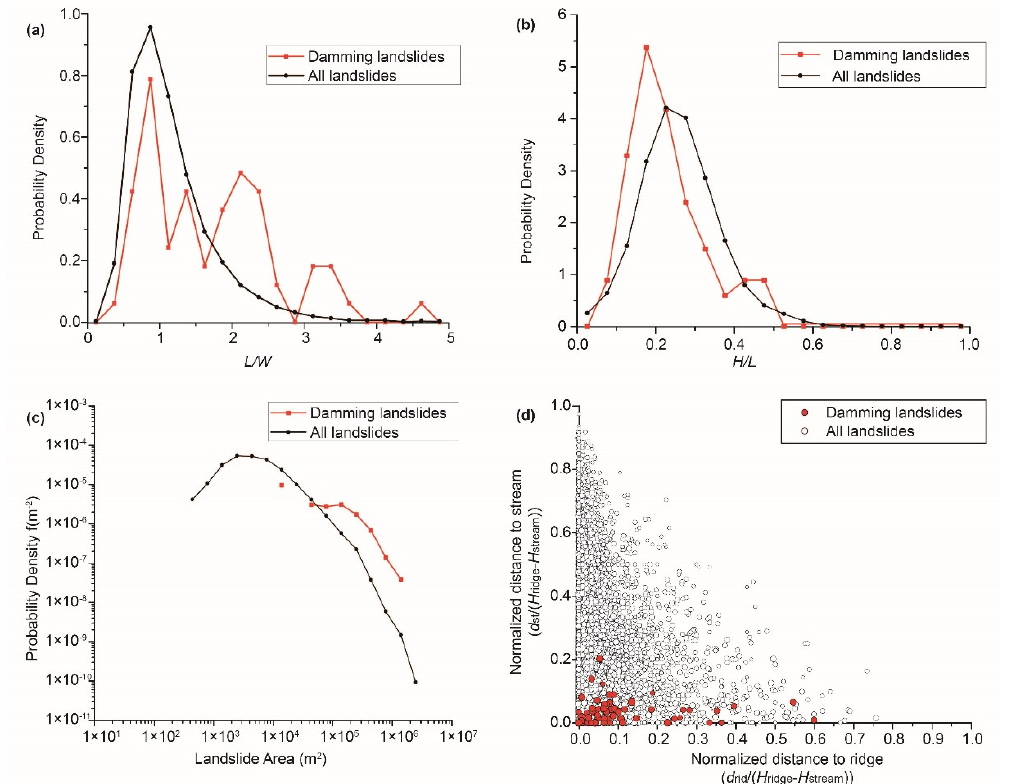
Figure 10. Geomorphic attributes of the Haiyuan coseismic damming and non-damming landslides (landslide data after Xu et al., 2021) [21]. ( a ) Aspect ratios of landslides. ( b ) Equivalent coefficients of friction. ( c ) Areas of landslides. ( d ) Normalized distances to ridges and streams, revealing the coseismic landslide distribution in slope portions. The horizontal axis is the normalized distance of the landslide boundary to the top of the slope (the ridge). The vertical axis is the normalized distance to the bottom of the slope (the river valley).